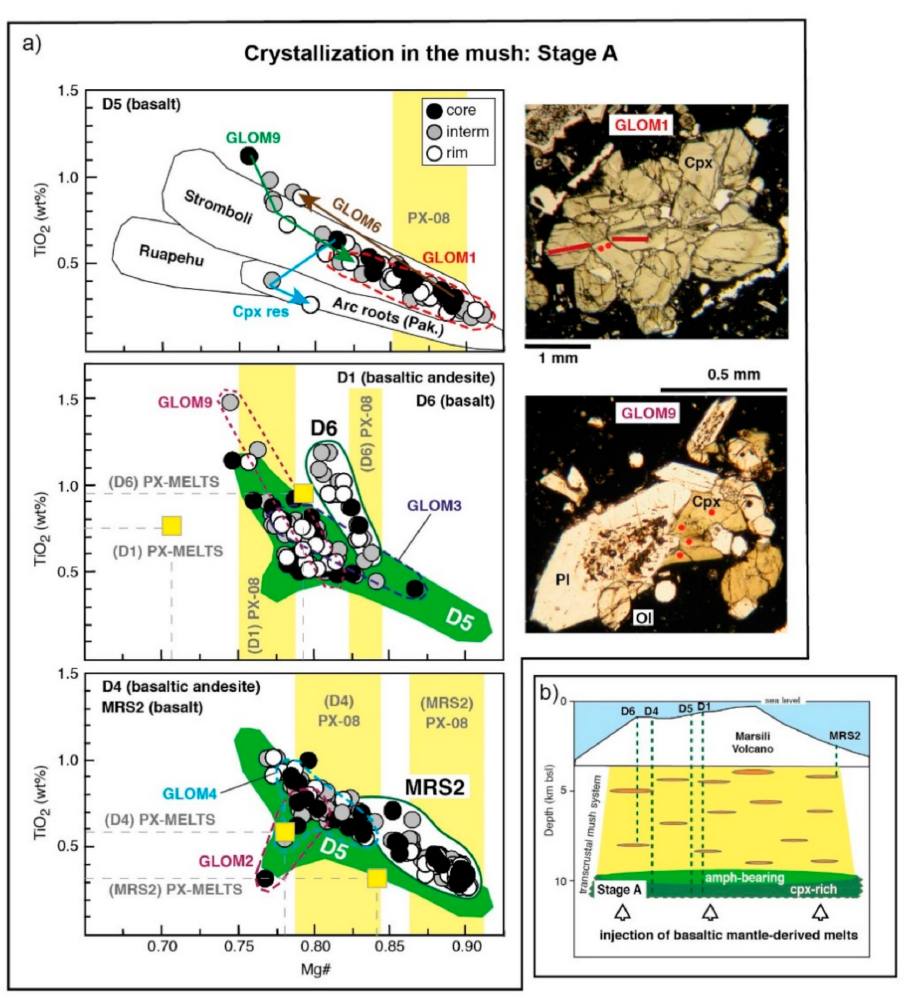
Figure 2. Clinopyroxene variability indicative of Stage A crystallization. ( a ) TiO 2 (wt%) versus Mg# for the clinopyroxene crystals in basalts to basaltic andesite lavas, top to bottom: D5; D1 and D6; MRS2 and D4. Estimated analytical error (2 standard deviation) was smaller than symbol size. The yellow box and the yellow vertical band refer to the Mg# equilibrium values indicated by the PX-MELTS [18] and the PX-08 (this study) results, respectively. Analyses of selected crystals (single or in glomerocrysts) are indicated with their abbreviation (see Supplementary Tables S2–S13) and marked with coloured arrows connecting core to rim or enclosed within dashed lines. The D5 clinopyroxene field is reported in green. Photomicrographs under parallel nicols are reported for some crystals (location of the analysed transects or points marked by red lines or dots, respectively); further photomicrographs are reported in Supporting Materials (Figure S1). Mineral abbreviations: Ol = olivine; Cpx = clinopyroxene; Pl = plagioclase; Glomerocrysts = GLOM. The Mg#-TiO 2 trend exhibited by these cargoes identifies “Stage A” cooling and crystallization during melt percolation at the pre-eruptive storage zone at the base of the MV crust, outlined in ( b ). Black lines enclose clinopyroxene compositions found at island-arc settings, recording growth in deep crustal mush environments: basic lavas from Stromboli [37] and Ruapehu [36]; exhumed island arc crustal sec- tion [35]. ( b ) Cross section of the multitiered magma plumbing system beneath Marsili Volcano, as in Figure 1c. Box “Stage A” marks location of deep crystallization events recorded by the D5, D4 and D1 clinopyroxene